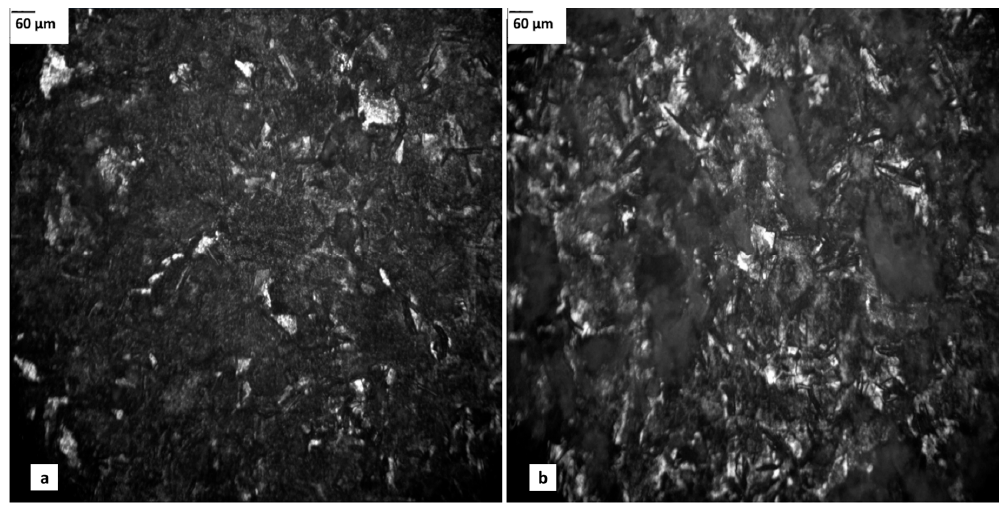
Figure 5. Images taken by a metallographic microscope for steel substrates with phosphate chemical coating: ( a ) after 2 min and ( b ) after 10 min deposition (magnification: ×10). coating: ( a ) after 2 min and ( b ) after 10 min deposition (magnification: ×